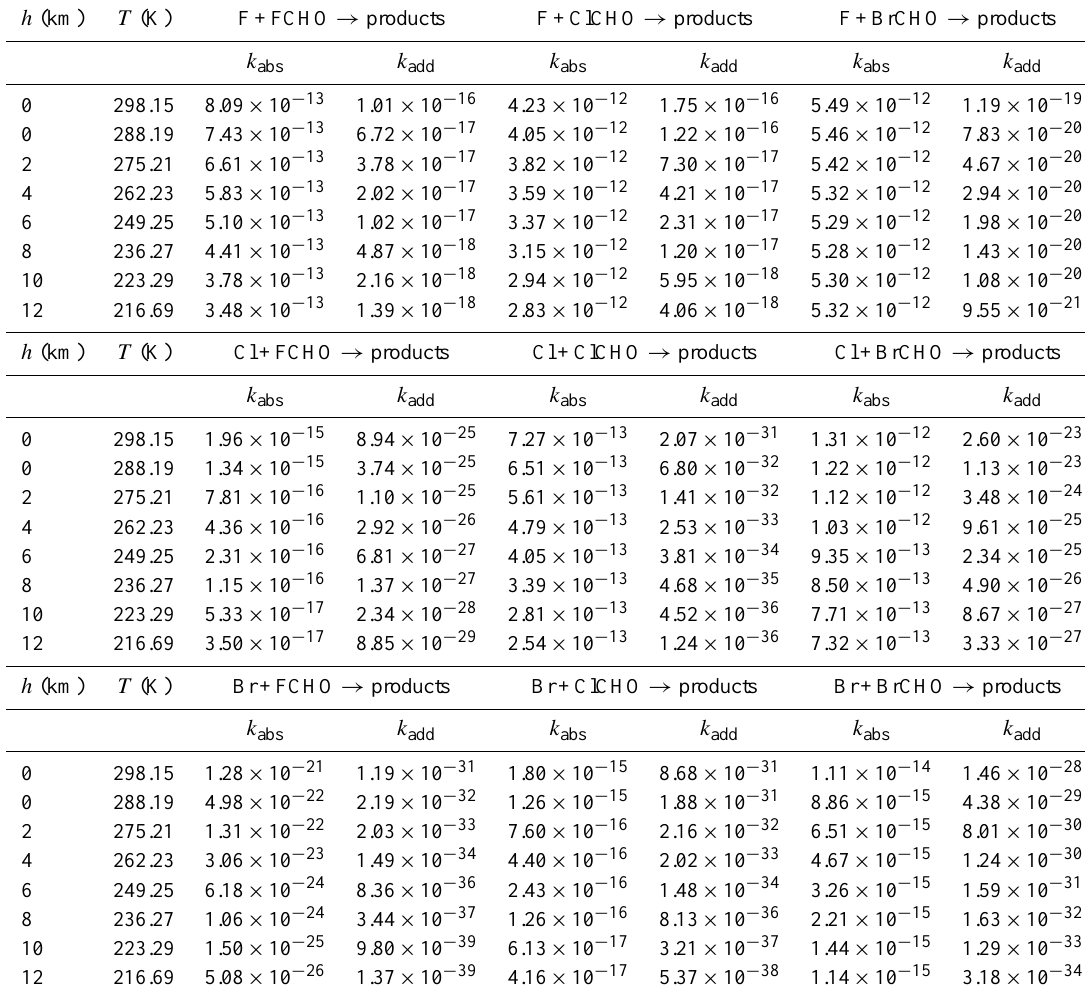
Table 4. Calculated CVT/SCT rate constants of H-abstraction and X-addition pathways at different heights ∗ in the earth atmosphere (in cm 3 molecule − 1 s − 1